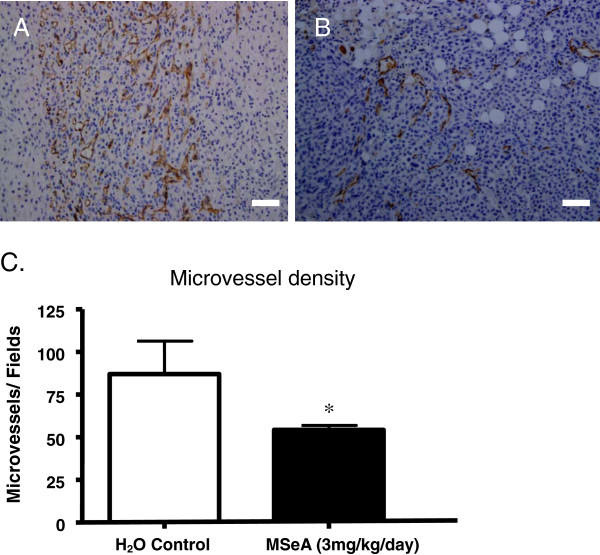
MSeA treatment significantly reduced the microvessel density of the xenograft tumor. A. Control. IHC staining for CD31 (brown) showed that the microvessel density was much higher in xenograft tumors from the nude mice received no oral administration of MSeA. B. MSeA treatment. Single dose oral administration of the nude mice with MSeA at 3 mg/kg/day x 18 days resulted in significant reduction in microvessel density, as indicated by CD31 IHC staining. Scale bar = 100 μm. C. Statistical summary of the microvessel density in the treatment and the control groups. A reduction of 38% in microvessel density was observed in the MSeA-treated nude mice (p < 0.05), with mean density for the control and MSeA-treatment group being 87±19 and 54±4, respectively (student-t test).